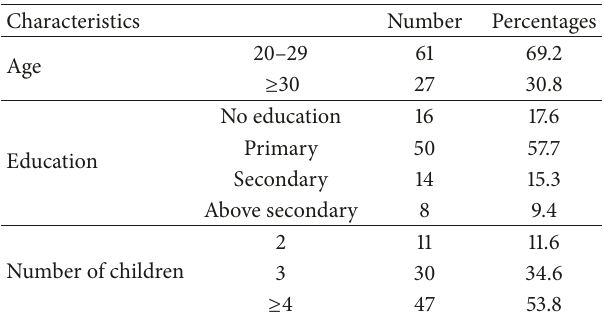
Table 2: Sociodemographic characteristics of women participants, Hadiya zone, Ethiopia,